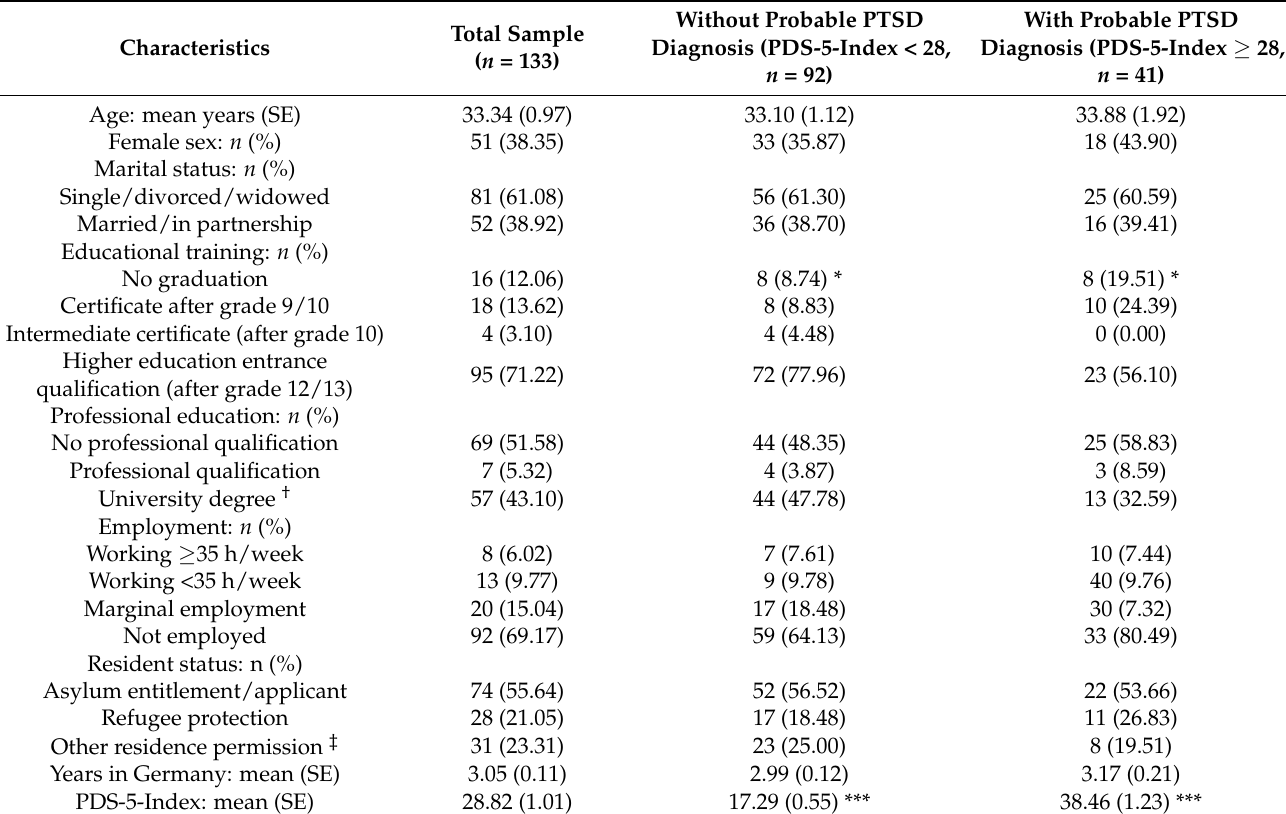
Table 1. Sample characteristics ( n =